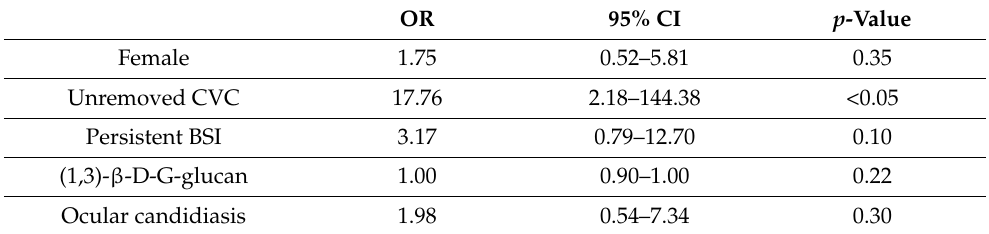
Table 5. Multivariate analysis of the factors associated with 30-day